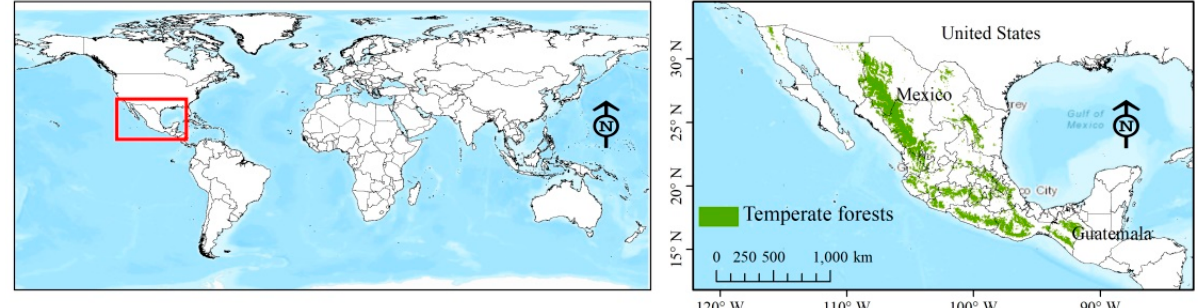
Figure 1. Study area that includes temperate forests.